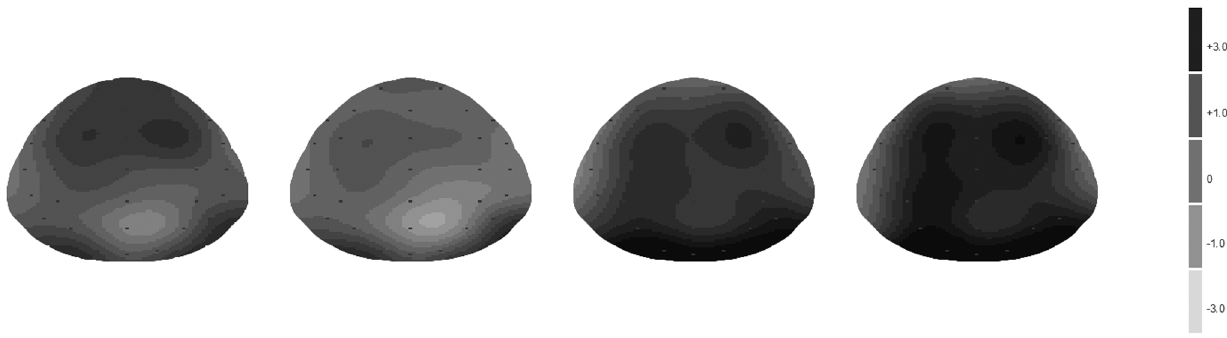
Figure 4. Voltage scalp maps of the P200 for four different trial types.